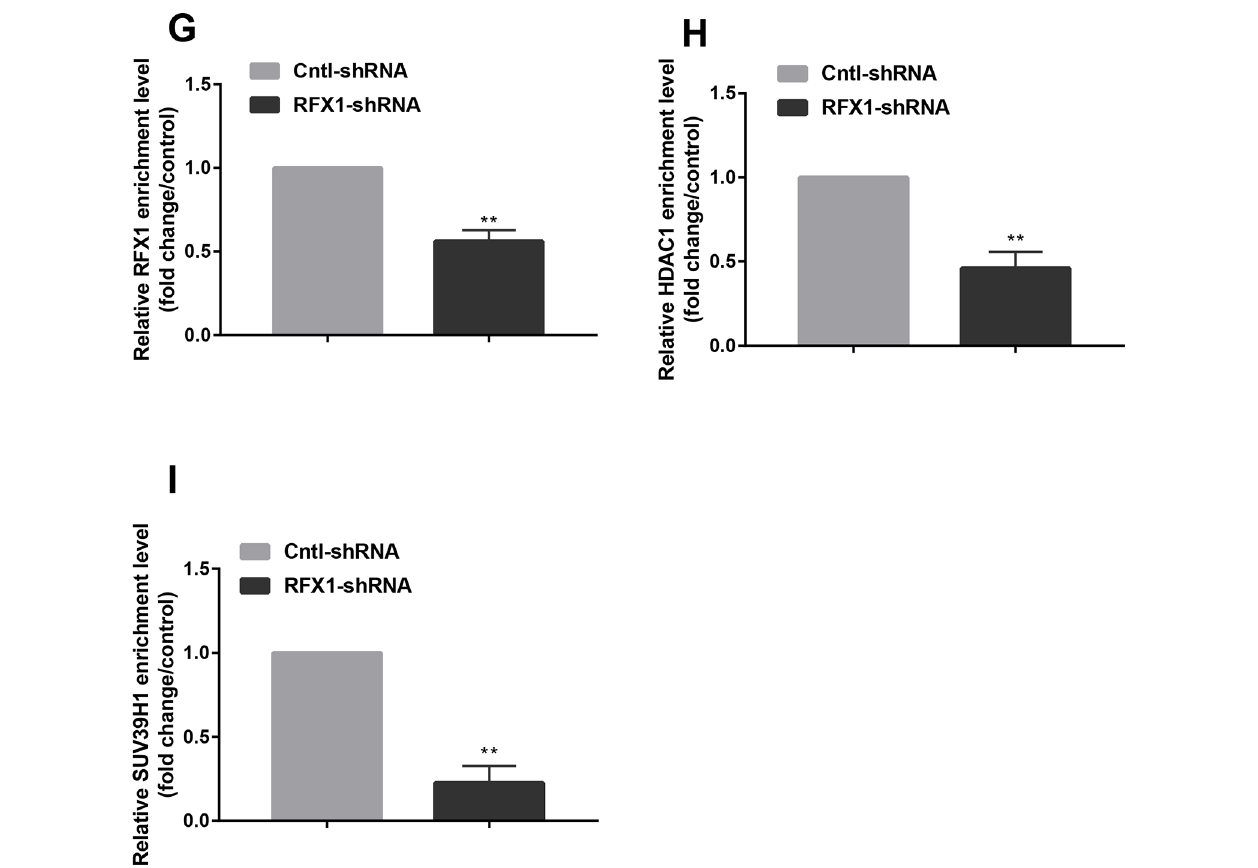
FigURE 4 | Knockdown of RFX1 caused the changes of histone modifications in MCP1 promoter. (a) The RFX1 protein expression was determined by western blotting in CD14+ monocytes transfected with RFX1-shRNA or Cntl-shRNA. (B–C) The relative MCP1 mRNA and protein expression were detected respectively by RT-qPCR and ELISA in CD14+ monocytes transfected with RFX1-shRNA or Cntl-shRNA. (D–F) The fold changes of relative H3 (D) and H4 (E) acetylation levels and H3K9 tri-methylation (F) level in CD14+ monocytes transfected with RFX1-shRNA or Cntl-shRNA was determined by ChIP-qPCR. (g–i) The fold changes of relative recruitments of RFX1 (g) , HDAC1 (H) and SUV39H1 (i) in the promoter region of the MCP1 gene were detected by ChIP-qPCR in CD14+ monocytes transfected with RFX1-shRNA or Cntl-shRNA. All values are the average of at least three biological replicates, and the data shown are the mean ± SEM. * P 0.05 and ** P 0.01 compared with the control